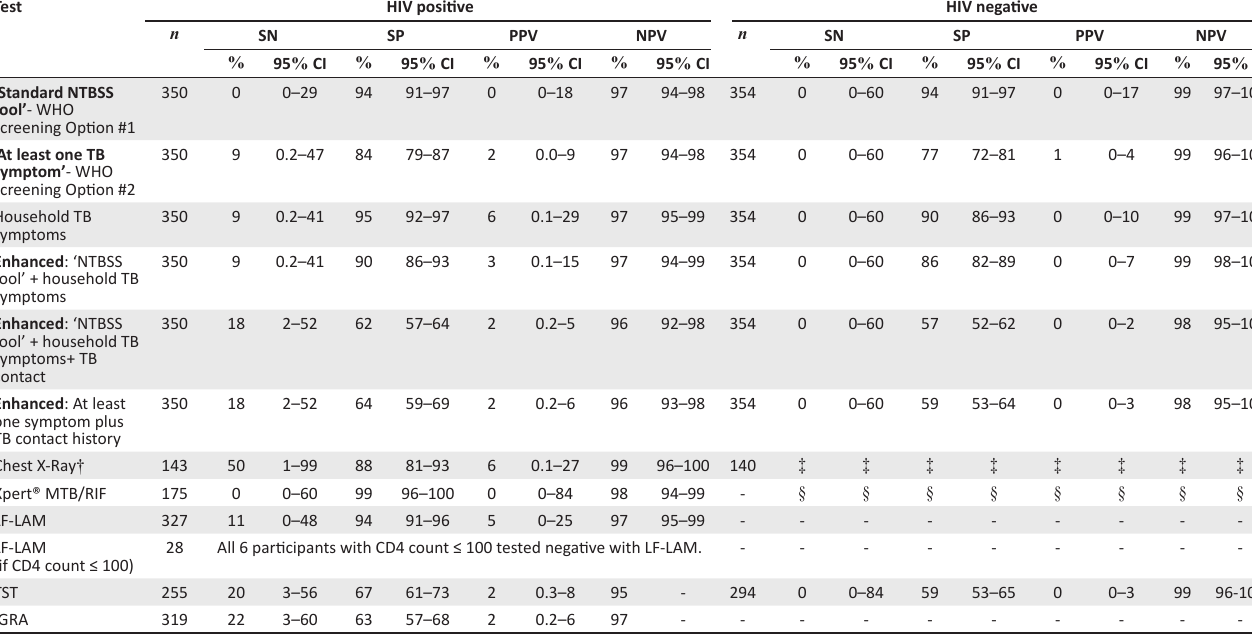
TABLE 3: Sensitivity, specificity, positive and negative predictive values of tuberculosis screening symptoms and diagnostic tests in pregnant and postpartum women attending antenatal and postnatal care clinics in Eswatini between April and November